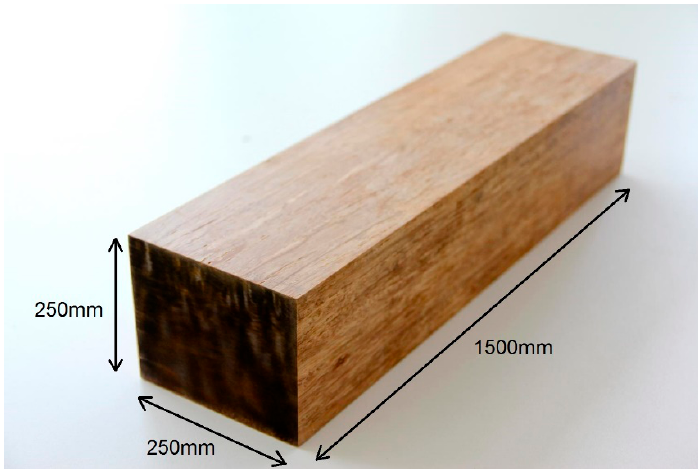
Figure 2. Bamboo composite sample developed in this study.